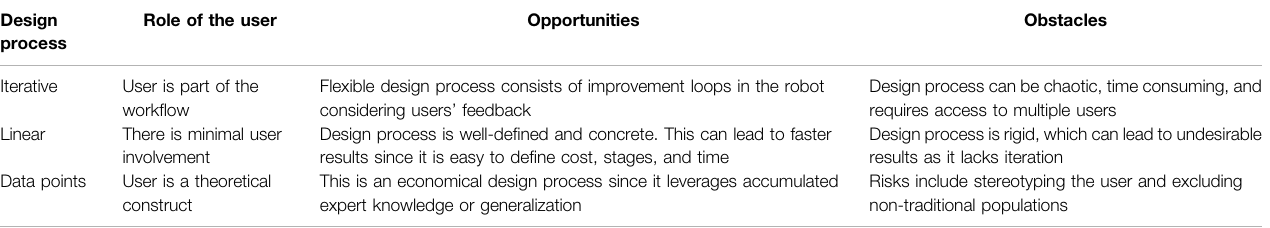
TABLE 2 | Synthesis of recommendations when designing new social